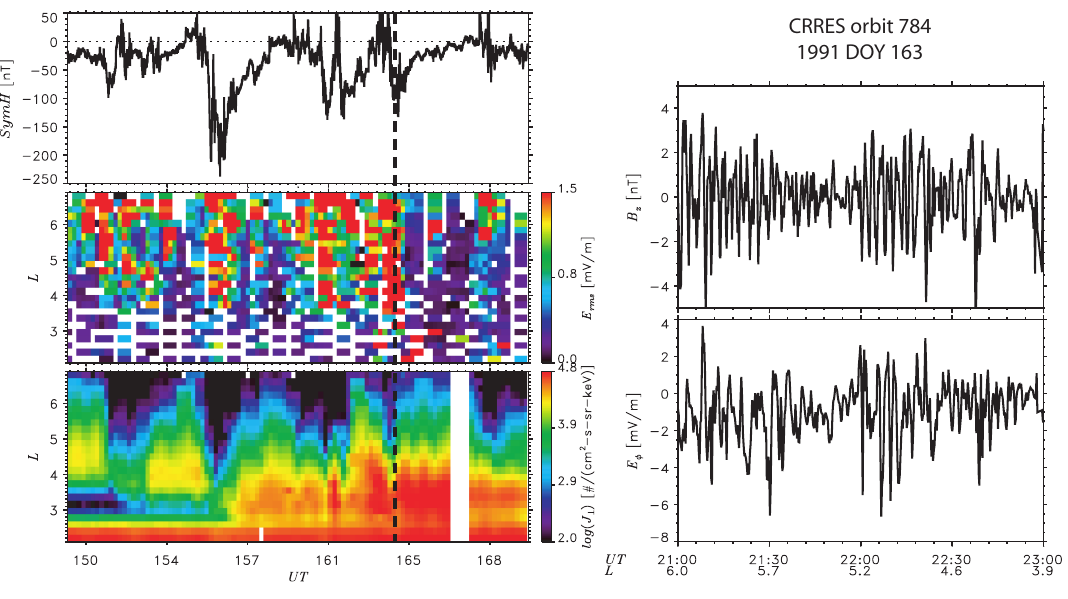
Fig. 2. Left panel: A survey of stormtime Pc5 (period < 10min) wave activity and variations of relativistic ( > 0.5MeV) electron fluxes measured by CRRES, plotted as a function of time and L . Right panel: E ϕ and B z oscillations associated with a stormtime Pc5 pulsation on DOY 163 (dashed line in the left